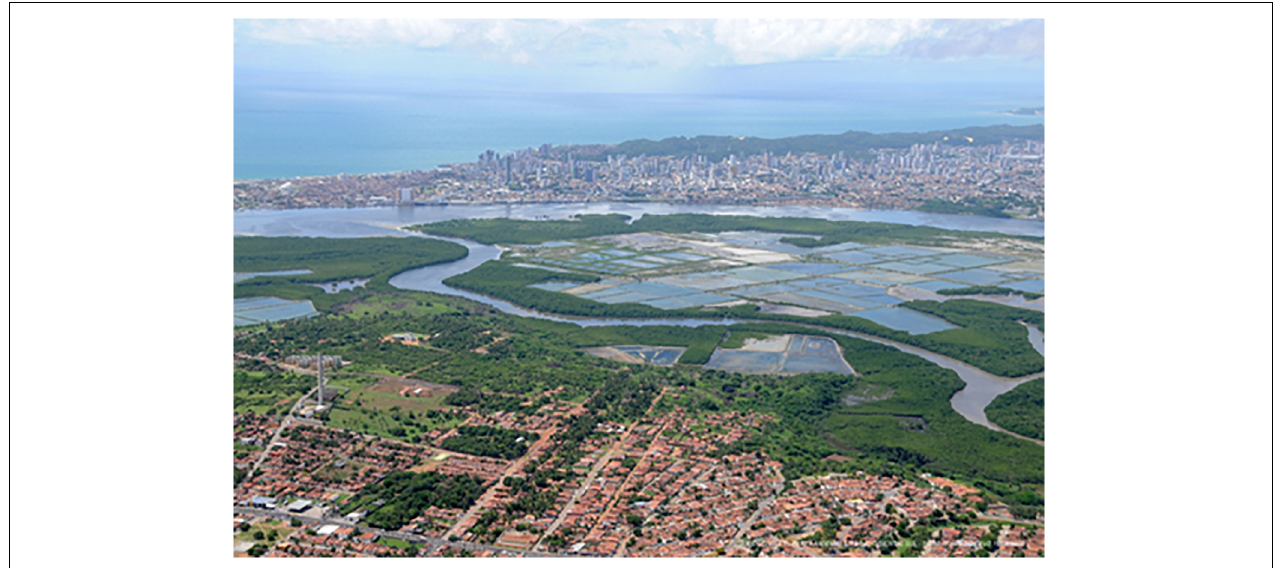
FIGURE 3 | Large mangrove cleared areas by shrimp farms at Potengi Estuary, Rio Grande do Norte State (Northeast Brazil). The mangrove island at the center-right of the image was almost totally converted to